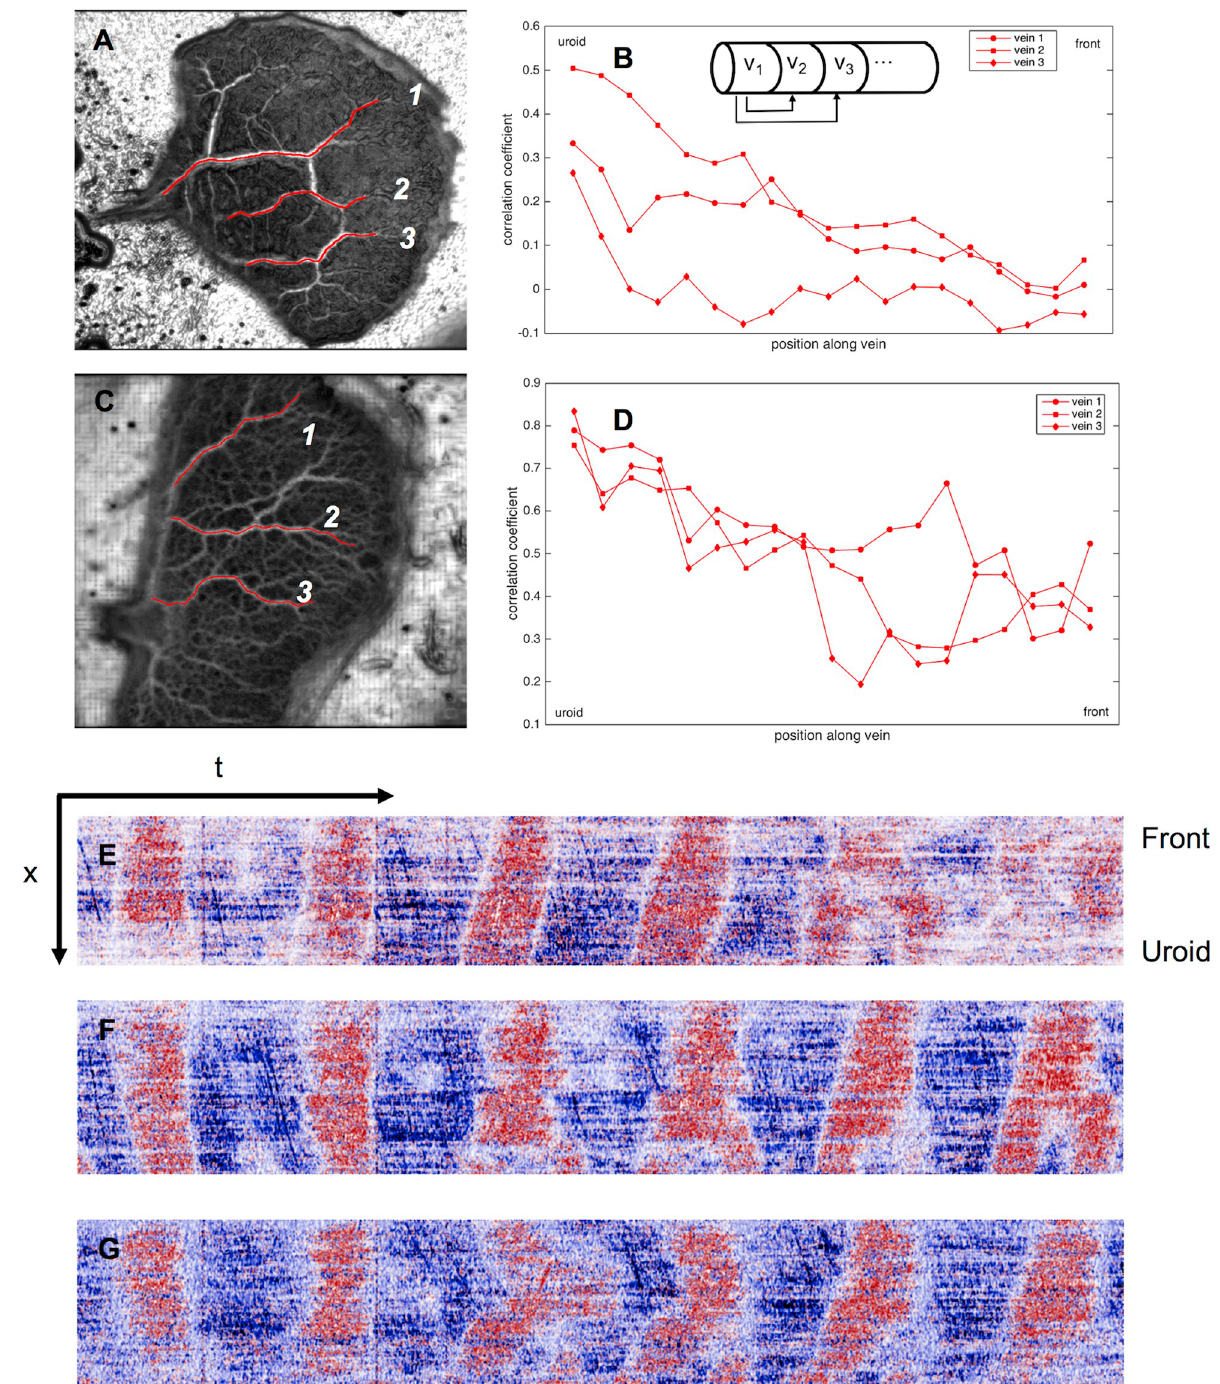
Fig 6. Flow pattern along veins. A) Satellite with acute uroid angle (time series over 7 minutes). Veins (red) run from uroid to front. B) Cross- correlation of flow velocities along the three veins. The velocity profile of the vein segment closest to the uroid is correlated with that of every subsequent segment along the vein (see inset). The correlation decreases slightly from back to front. C) and D) Similar analysis for satellite with obtuse angle. Time series over 14.5 minutes. E-G) Kymographs (see method section Analysis of leading edge velocity) taken along three veins of the mesoplasmodium in C), denoted with numbers 4-6. x = spatial dimension (each vein is � 800 μ m long), t = time ( � 15 min). Bottom edge of each kymograph corresponds to vein area close to uroid; top edge is closest to the front. Along each vein, the transition from uroidal to frontal oscillation pattern (frequency selection) can be observed: The oscillation frequency is almost twice as high closest to the uroid as near the front.